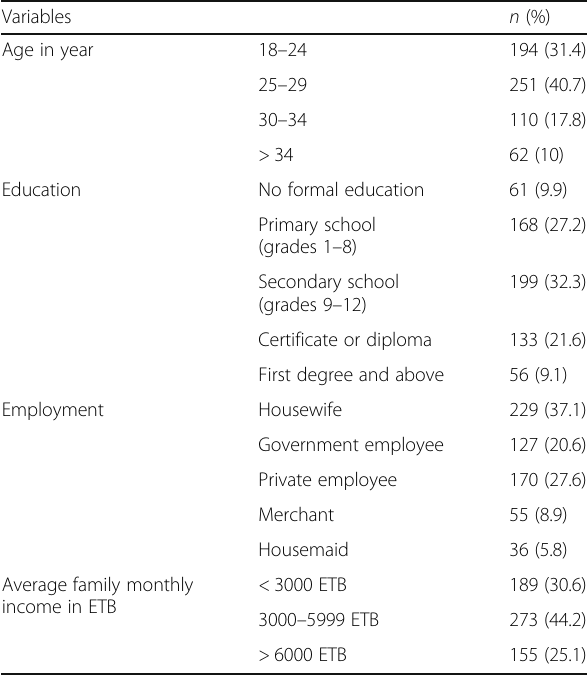
Table 1 Socio-demographic characteristics of the